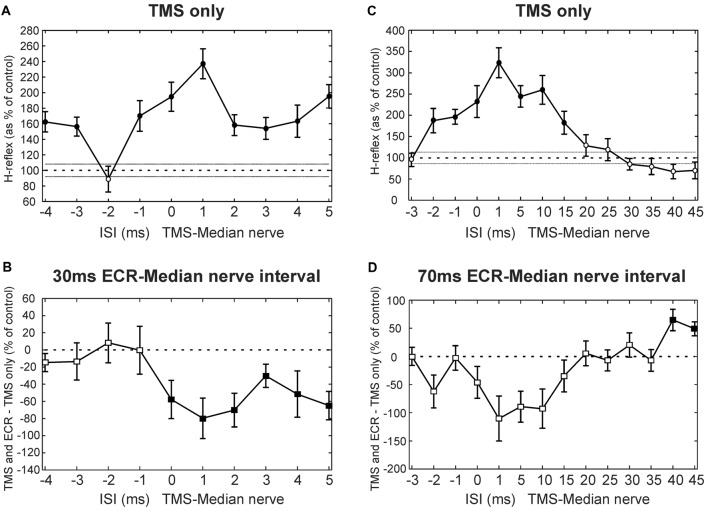
Transcranial magnetic stimulation (TMS) results from single subjects. (A) Effects of TMS on the flexor carpi radialis (FCR) H-reflex at different inter-stimulus intervals (ISIs) from a single subject. (B) Difference between the effect of TMS on the H reflex, and the effect of TMS on the H reflex conditioned by ECR stimulation 30 ms before the median nerve shock. Same subject as (A). (C) Effects of TMS on the FCR H-reflex, for different ISIs and a different subject from (A). (D) Difference between effect of TMS on H reflex, and on H reflex conditioned by ECR stimulation 70 ms before the median nerve shock. Same subject as (D). In (A,C), the peak-peak amplitude of the H reflex is plotted as a function of ISI, as a percentage of the size of the unconditioned H reflex. Filled symbols show points significantly different from 100% (A,C) or 0% (B,D). Error bars indicate standard error of the mean.